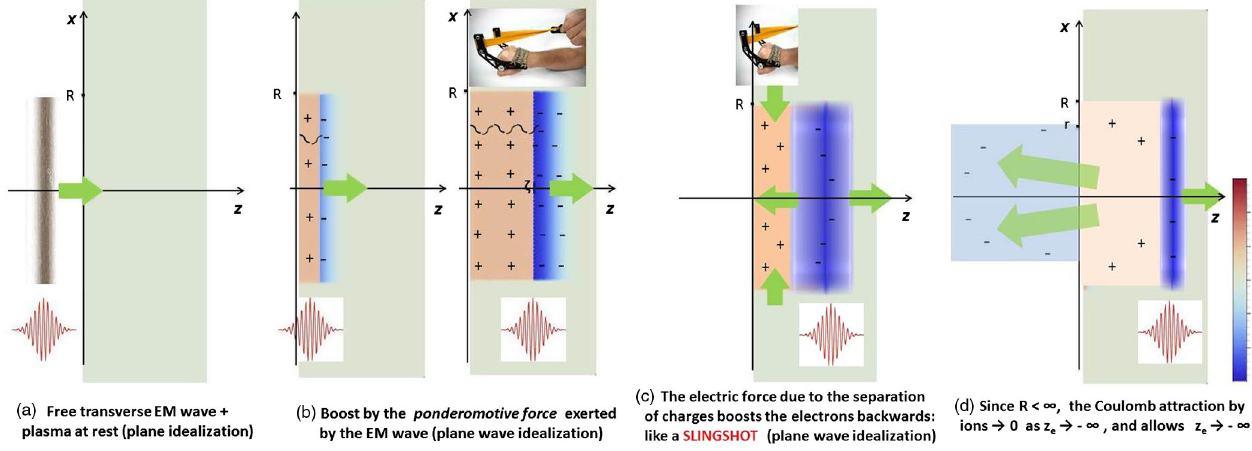
FIG. 1. Schematic stages of the slingshot